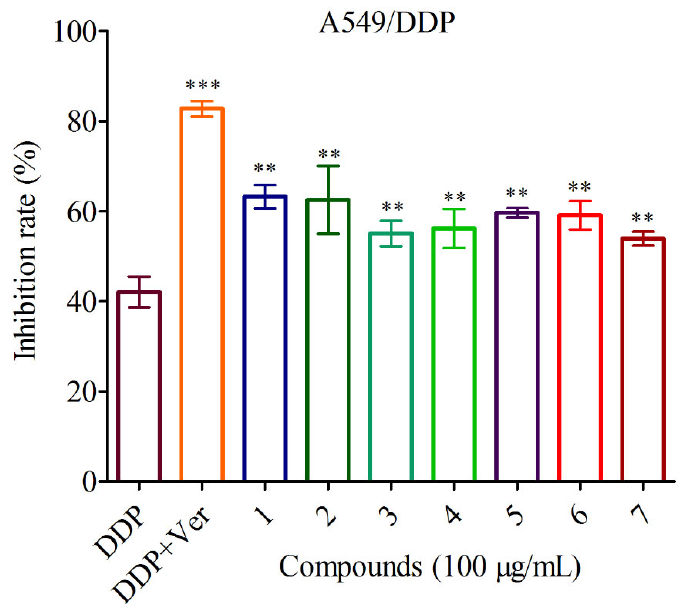
Figure 8. Reversal activities of the isolates at concentration of 100 µg/mL against A549/DDP.